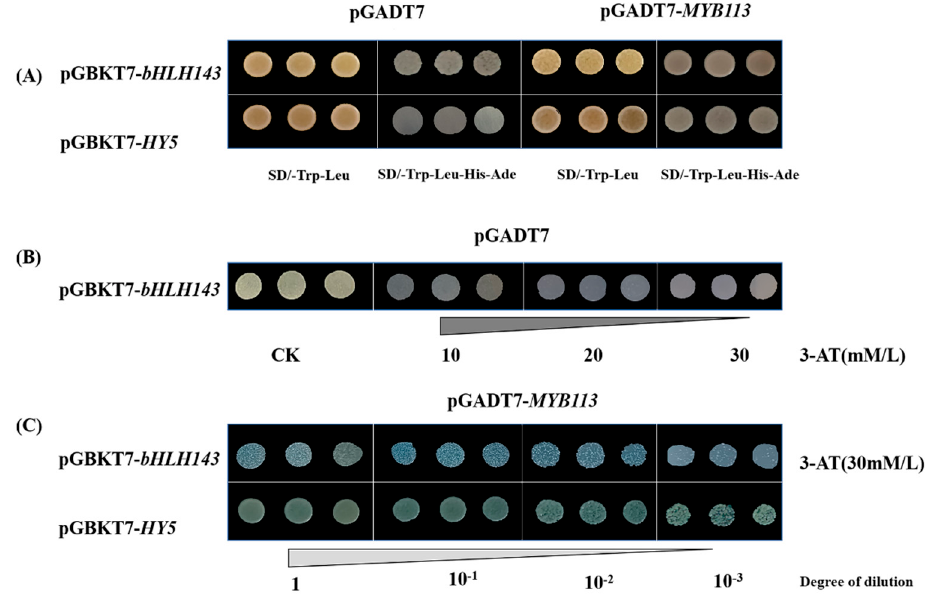
Figure 4. CaMYB113 interacted with CaHY5 and CabHLH143. ( A ) pGBKT7- bHLH143 has self-activation on SD/-Trp-Leu-His-Ade, and pGBKT7- HY5 does not. ( B ) Growth conditions of pGBKT7- bHLH143 + pGADT7 on SD/-Trp-Leu-His-Ade with different concentrations of 3-AT. ( C ) CaMYB113 interacts with CabHLH143 and CaHY5 in yeast cells. The minimum concentration of 3-AT required to inhibit self-activation of pGBKT7- bHLH143 is 30 mM/L. Four black squares represent four dilution concentrations. There are three replicates for each concentration of each combination.